Question: Express in one sentence what the figure is showing.
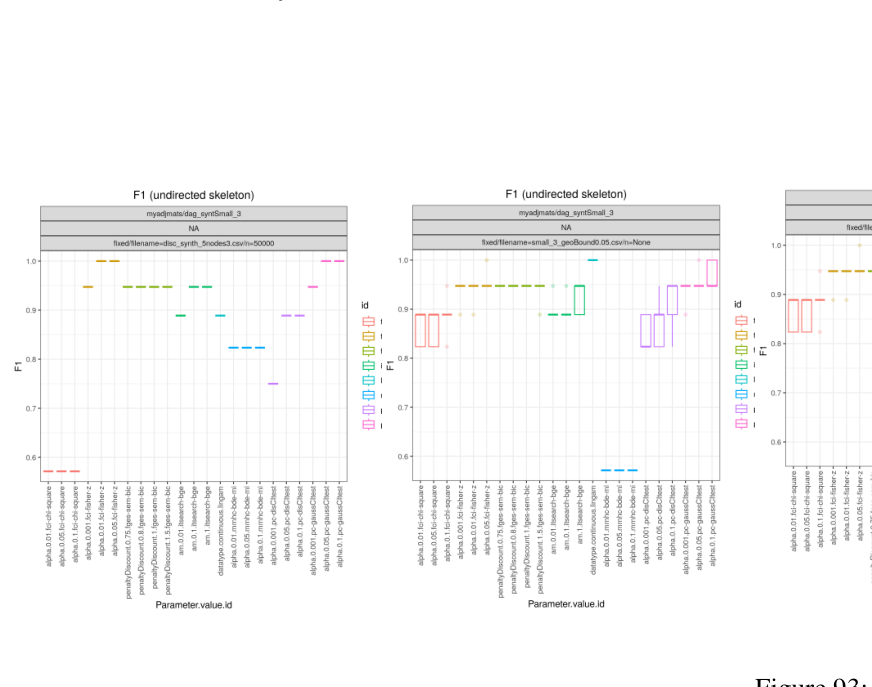
Answer: F1 Scores on the Synthetic 5 nodes data set. Dis- cretized, no noise.